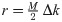
Acquisition Trajectories: (a) Definition of the coordinate system for the radial readout spokes. (b) Illustration of circles of constant latitude on a spherical surface of radius r=M2Δk. Each readout spoke points to a different end position on these circles and the endpoints are evenly distributed on the circles. (c) Resulting 3D distribution of measured spokes.